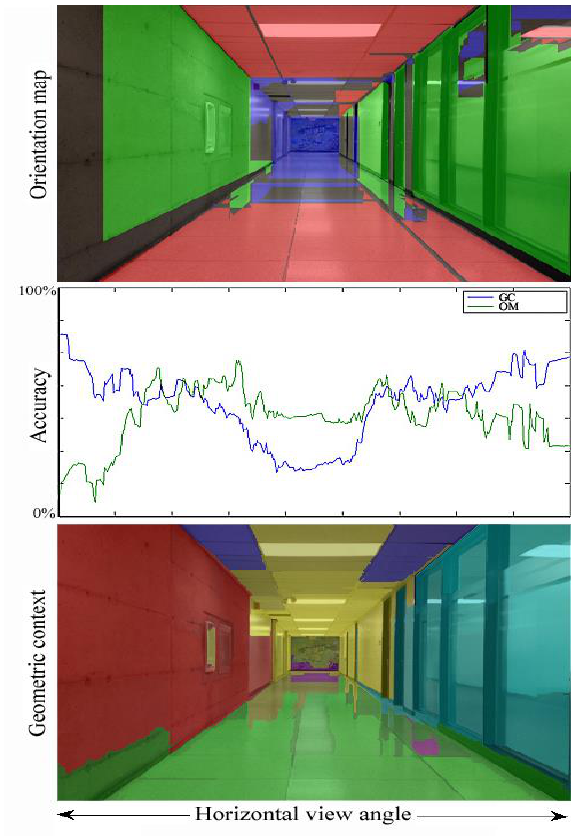
Figure 6. Orientation Map and Geometric Context accuracy changes by changing the horizontal viewing